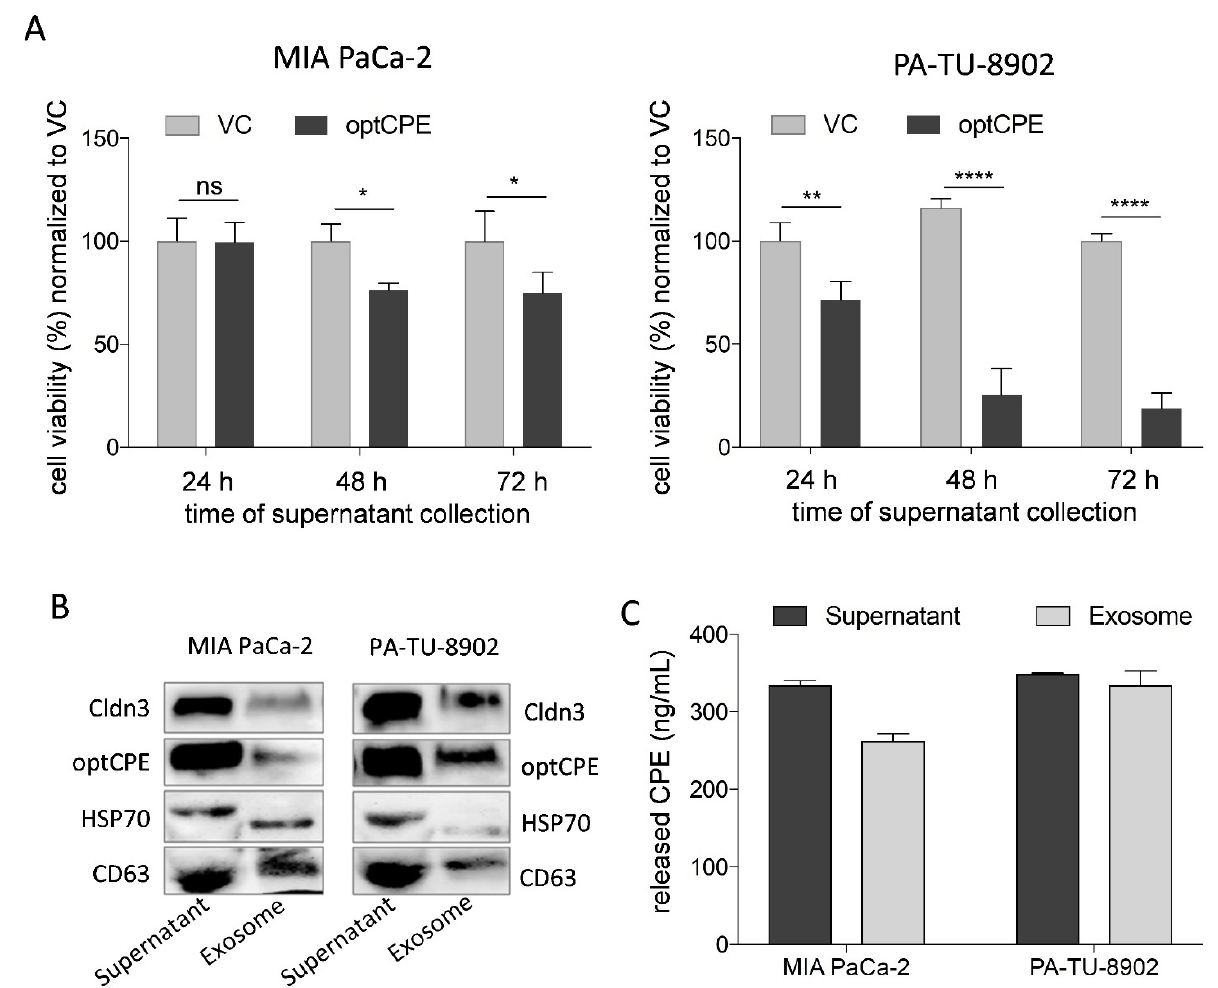
Figure 4. Analysis of bystander effect and of CPE release via exosomes in optCPE-transfected PC cells. ( A ) Analysis of cytotoxicity of released optCPE. Media of vector control (VC) or optCPE-transfected MIA PaCa-2 and PA-TU-8902 cells collected at 24 h, 48 h and 72 h were added to respective non-transfected cells. After 72 h cytotoxicity was determined by MTT. Significant reduction of viability in PA-TU-8902 and MIA PaCa-2 cells was induced by supernatants collected 48 h and 72 h after transfection. For PA-TU-8902 cells, higher toxicity was observed than in MIA PaCa-2 cells. This correlated with the released optCPE amount. ( B ) Western blot of supernatant and exosomes (specific exosomal marker heat shock protein 70, HSP70 and tetraspanin CD63, Figure S7) from transfected MIA PaCa-2 and PA-TU-8902 cells. ( C ) Quantification of optCPE within supernatant and exosomes of optCPE-transfected MIA(cid:31)(cid:31)(cid:31)PaCa-2 and PA-TU-8902 cells by CPE ELISA revealed concentrations of 324.4 and 382.7 ng mL − 1 CPE in supernatant and 242.6 and 344.5 ng mL − 1 CPE in exosomes, respectively. Data are represented as mean values ± S.D. ( n = 3), expressed as mean percentage of VC. (* p < 0.05; ** p < 0.01; **** p < 0.0001).